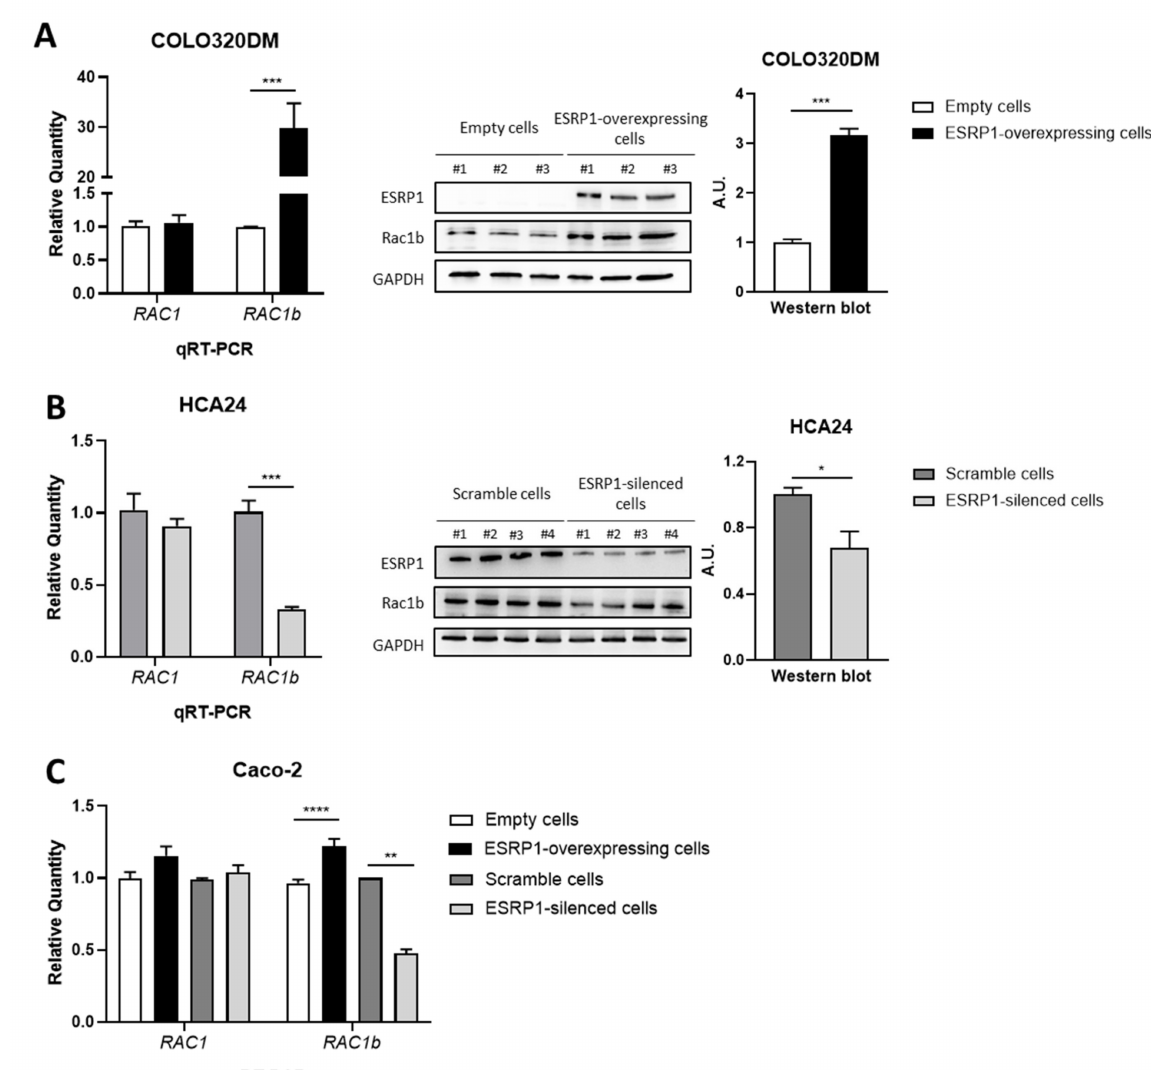
Figure 4. RAC1b data validation in all CRC cell lines under study. ( A ) RAC1b up-regulation in COLO320DM cells was validated by qRT-PCR (on the left) and Western blot (on the right) analysis ( n = 5 for qRT-PCR and n = 3 for Western blot). ( B ) RAC1b down-regulation in HCA24 cells was validated by qRT-PCR (on the left) and Western blot (on the right) analysis ( n = 4). ( C ) RAC1b deregulation upon ESRP1 modulation in Caco-2 cells was validated by qRT-PCR ( n = 3). RAC1 expression levels were evaluated by qRT-PCR analysis in all CRC cell lines. Data are expressed as mean ± SEM of relative quantification using the delta–delta Ct method over control (empty and scramble) cells. Normalization was made using GAPDH as housekeeping gene. Unpaired t-test was performed: * p < 0.05, ** p < 0.01, *** p < 0.001, **** p <